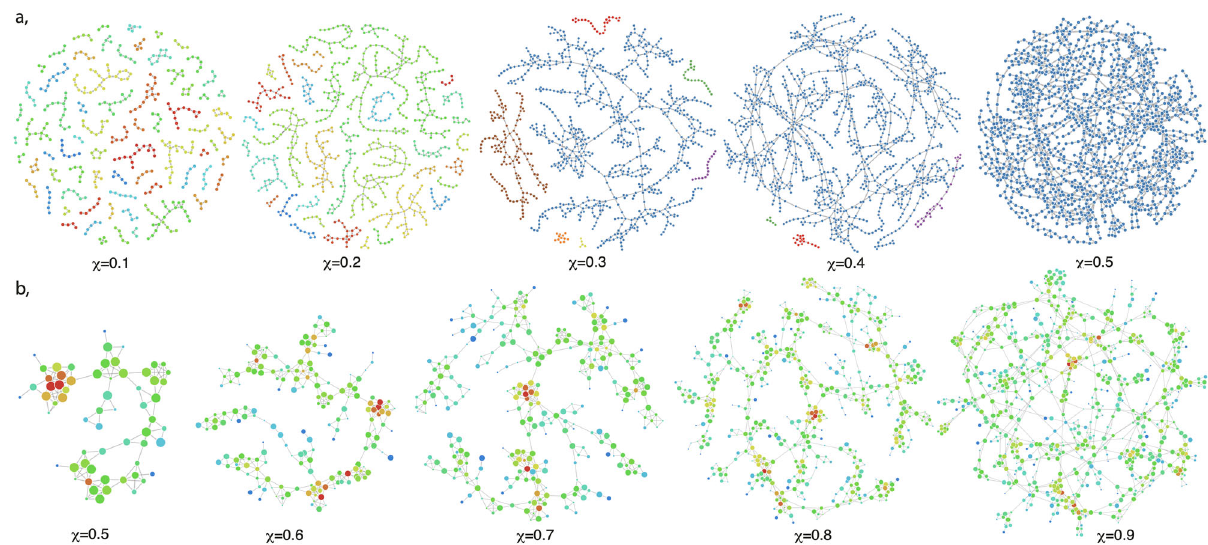
Fig. 3 Two-dimensional layouts of networks and cell-complexes developing in polymerising DDDA. a Network structures with highlighted components. The fi rst percolation transition is thought to take place at χ = 0.2 and shortly afterwards the whole system predominantly consists of one connected component (isolated nodes not shown). The largest component continues to evolve as new bonds appear internally. b Evolution of the largest connected component in the cell complex. Nodes represent holes in the former network: node size represents the size of the hole, with smallest nodes corresponding to size 3 and the largest to size 6. The second percolation transition is thought to take place at χ = 0.7, wherein the whole cell complex becomes spanned by a component of an extensive size, which severely restricts mobility of the polymer network.